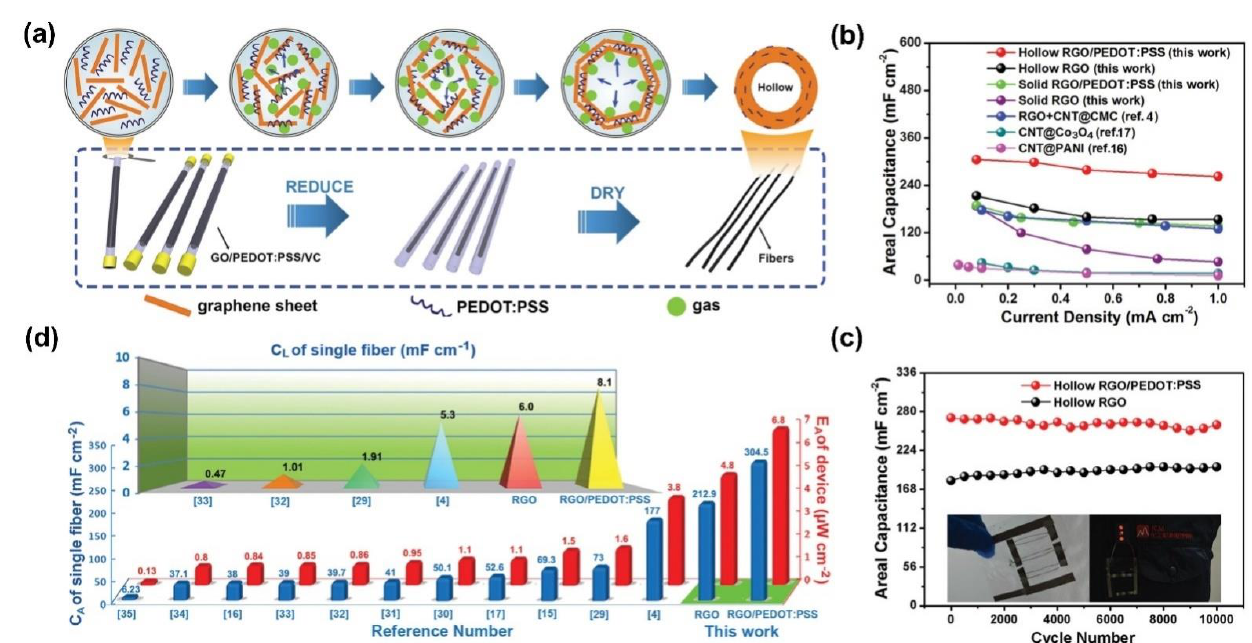
Figure 9. ( a ) Schematic illustrationof preparation of hollow rGO/conducting polymer composite fibers; ( b ) Areal specific capacitances ofcomposite fiber supercapacitorsat increasing current densities; ( c ) Long-term cyclic stability of the composite fiber supercapacitors; ( d ) Comparison of the electrochemical performances of composite fiber supercapacitors with that of the other fiber-shaped supercapacitors in areal specific capacitance (C A ), length specific capacitance (C L ), and areal energy density (E A ) [98] (copyright permission Wiley-VCH 2016).